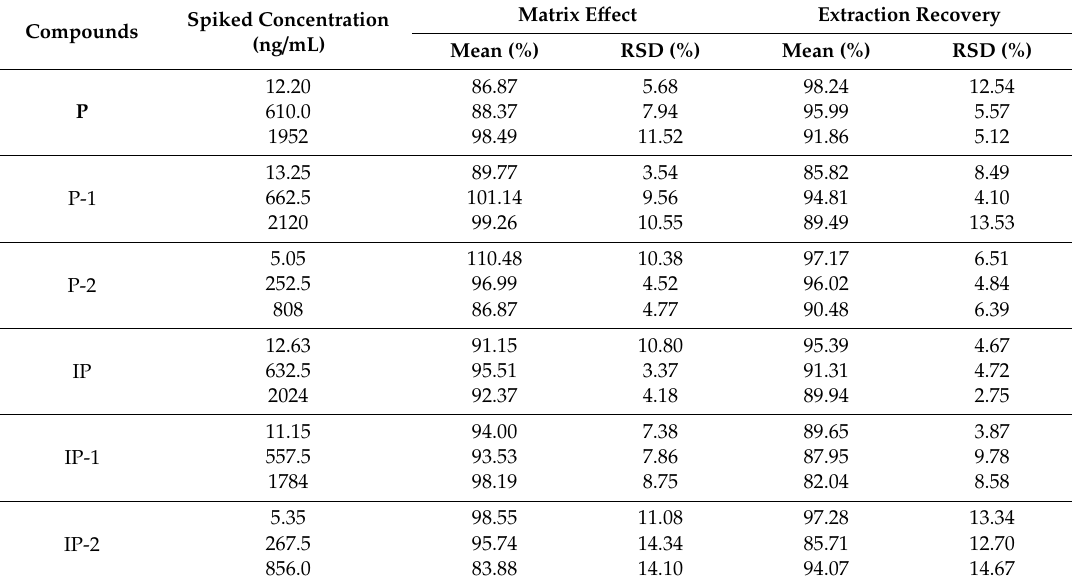
Table 4. Matrix e ff ects and extraction recovery for the analytes in human intestinal flora ( n = 6). Matrix E ff ect Extraction Recovery Spiked Concentration Compounds (ng / mL) Mean (%) RSD